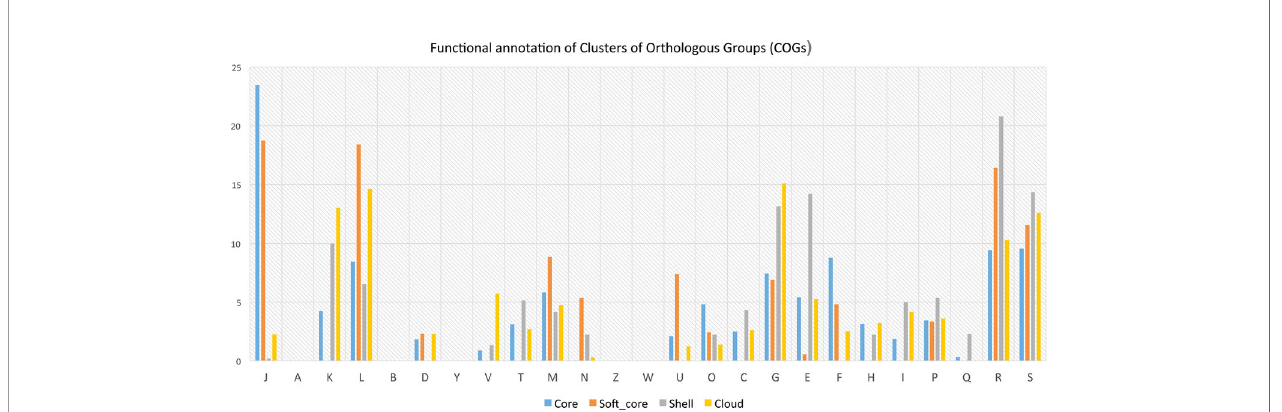
FIGURE 4 | Bar plot showing distribution of COGs in core, softcore, shell and cloud subset of pan-genome J: Translation, ribosomal structure and biogenesis, A: RNA processing and modi fi cation, K: Transcription, L: Replication, recombination and repair, B: Chromatin structure and dynamics, D: Cell cycle control, cell division, chromosome partitioning, Y: Nuclear structure, V: Defense mechanisms, T: Signal transduction mechanisms, M: Cell wall/membrane/envelope biogenesis, N: Cell motility, Z: Cytoskeleton, W: Extracellular structures,U: Intracellular traf fi cking, secretion, and vesicular transport, O: Posttranslational modi fi cation, protein turnover, chaperones, C: Energy production and conversion, G: Carbohydrate transport and metabolism, E: Amino acid transport and metabolism, F: Nucleotide transport and metabolism, H: Coenzyme transport and metabolism, I: Lipid transport and metabolism, >P:Inorganic ion transport and metabolism, Q: Secondary metabolites biosynthesis, transport and catabolism, R: General function prediction only, S: Function